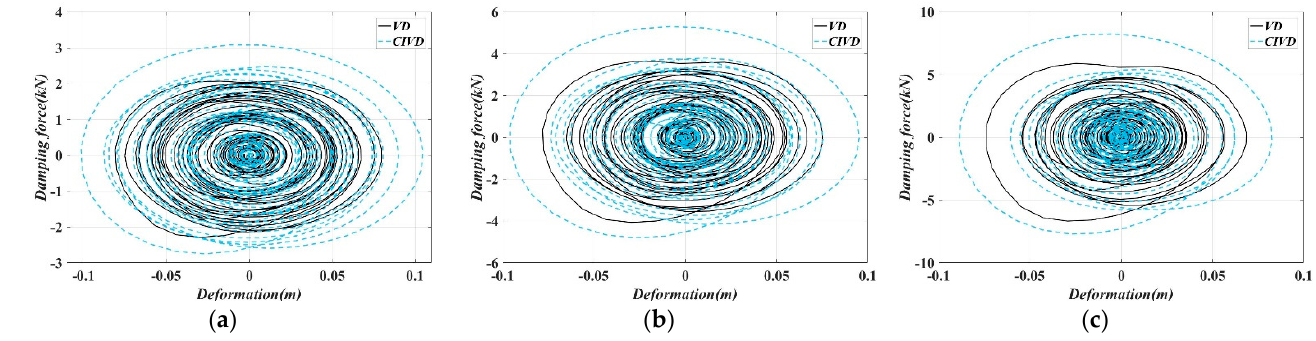
Figure 21. Hysteretic loops damping element of CIVD in SC eave under EL Centro record: ( a ) γ Ur = 0.7; ( b ) γ Ur = 0.6; and ( c ) γ Ur = 0.5.